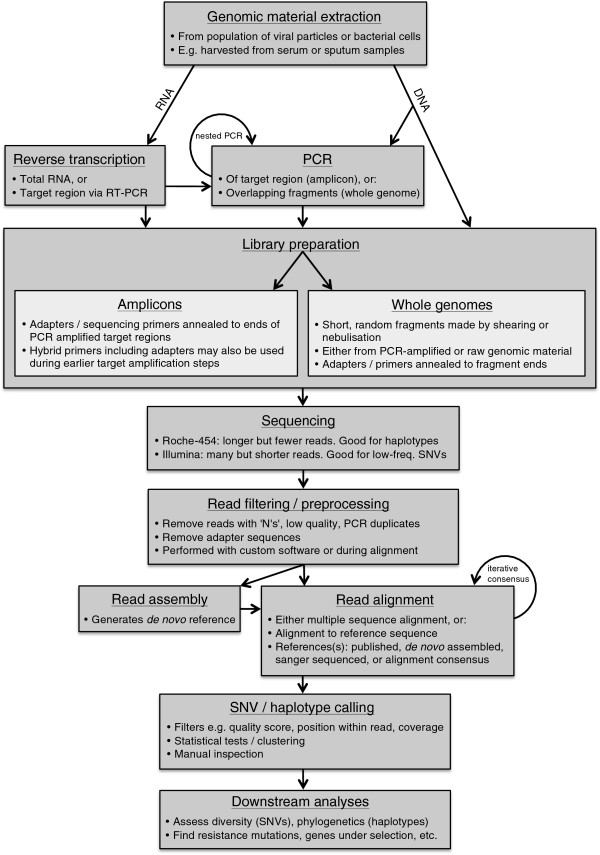
Flowchart detailing pipeline steps required for deep sequencing projects. After extracting genomic material, PCR amplification may be required prior to library preparation. For sequencing of a target region (‘amplicon sequencing’), multiple, ‘nested’ PCR rounds may be performed. Sequencing adapters and primers may be included in the primer for the final round, or may be annealed to the ends of fragments after amplification. For whole genome sequencing, multiple, overlapping PCR products are randomly sheared before annealing of sequencing adapters and primers. Alternatively, if sufficient genomic material is available, shearing and annealing may be performed directly without PCR amplification. If sequencing RNA, RT must be performed before library preparation. For amplicon sequencing, this may take the form of an initial RT-PCR. Choice of sequencing technology is dependent on the project’s aims: for instance, the longer reads of Roche-454 may be more appropriate for reconstructing haplotypes, while the high data volume afforded by Illumina is more suitable for detecting very low frequency SNVs. After sequencing, reads must be aligned, either via multiple sequence alignment or to a reference. Choice of reference is critical; if available, a published reference or references may be used; alternatively, a consensus sequence may be used, generated through de novo assembly, or by alignment to a published reference followed by replacement of fixed variants, or by Sanger sequencing the same sample as submitted for deep sequencing. Following alignment, a number of bioinformatic tools are available for SNV calling, haplotype reconstruction, and downstream analysis.